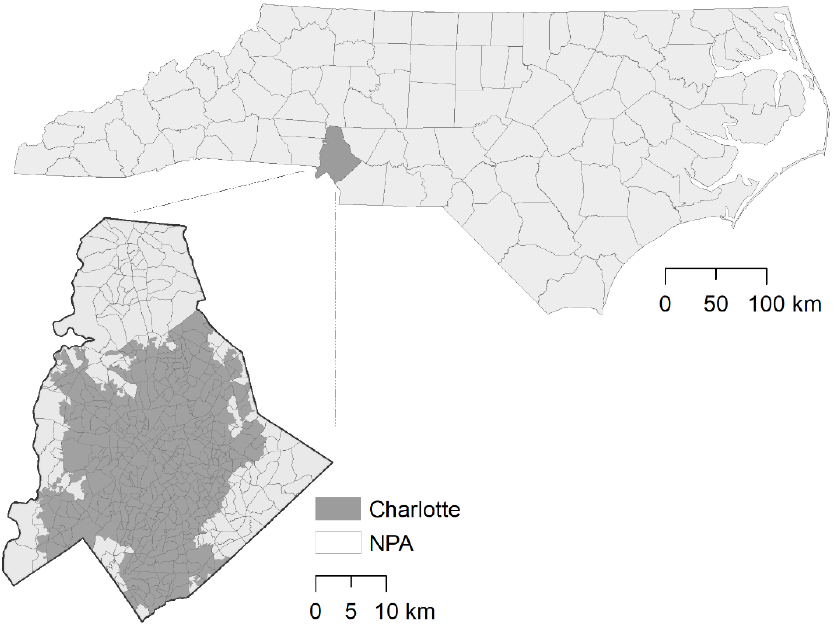
Figure 1. Location of Mecklenburg County and Charlotte city limits in North Carolina (NPA = Neighborhood Planning